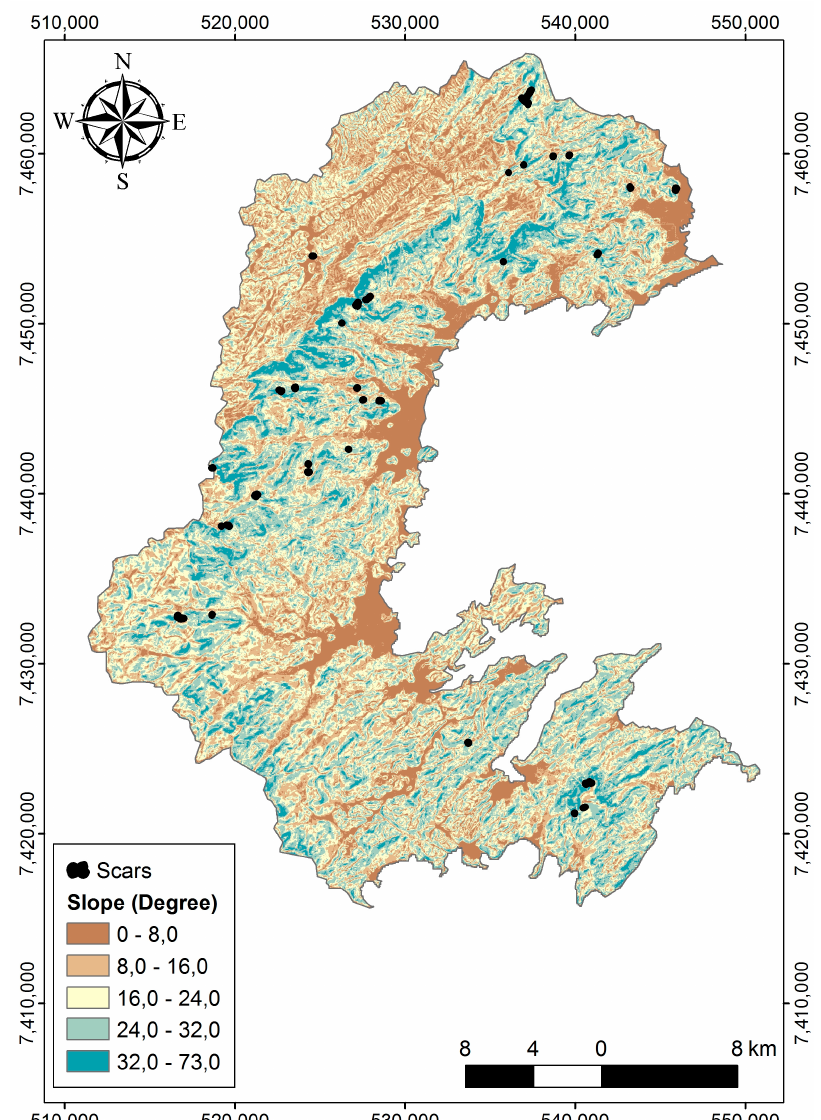
Figure 5. Scar distribution according to the average rainfall rate.